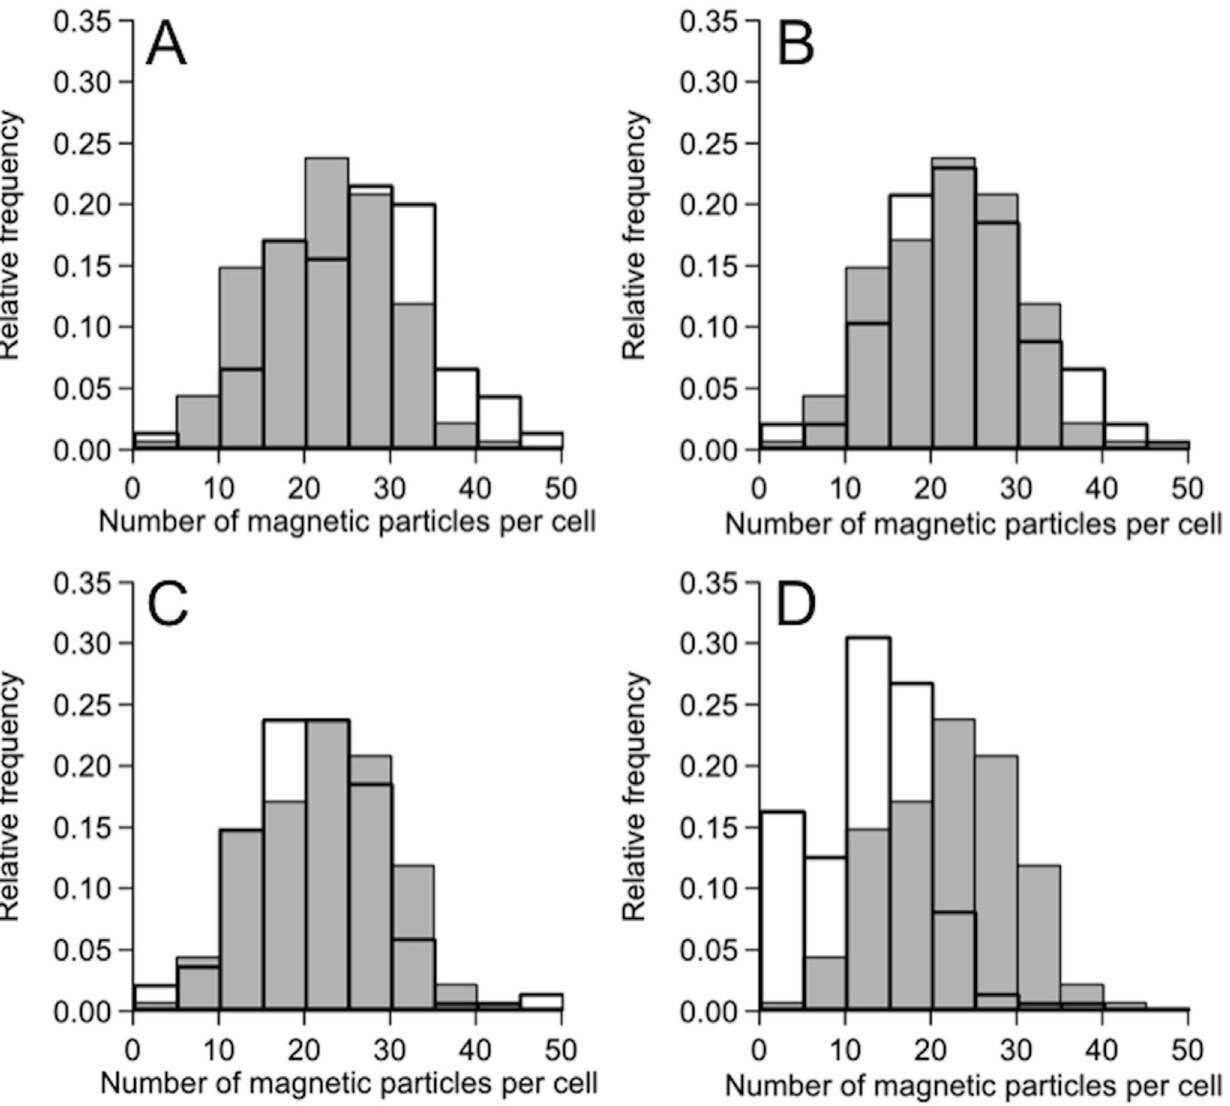
Fig 3. Distribution of the number of magnetosomes in each cell grown in the culture medium containing PEGs. (A), (B), (C), (D) Magnetosomes synthesized in the presence of 0.5% PEG200, 0.5% PEG6,000, 0.5% PEG20,000, and 0.5% PEG500,000. The histograms represent the number distributions of magnetosomes in the absence (gray bars) and presence (solid bars) of